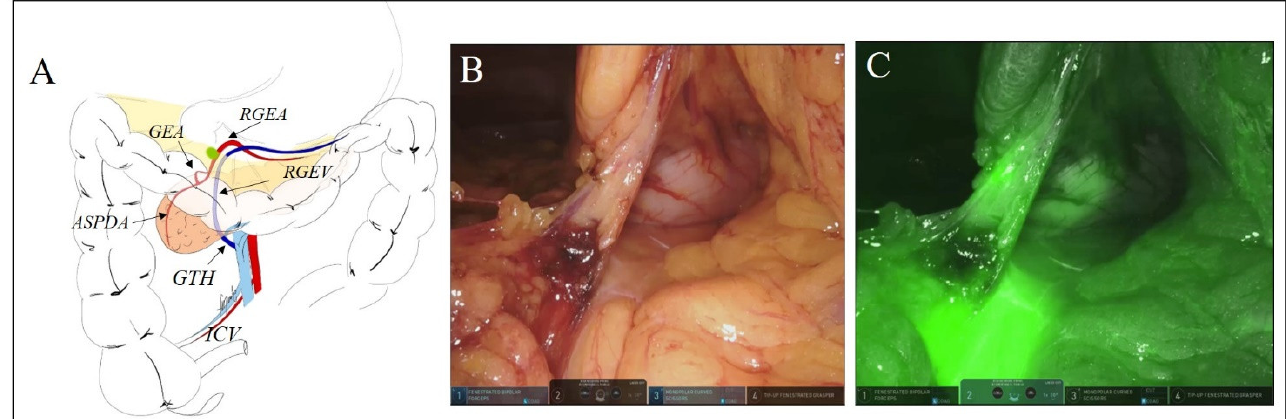
Figure 2. Sketch of the surgical field ( A ) and corresponding intraoperative pictures under white ( B ) and NIR ( C ) light of a female patient (#GLTr 7) undergoing robotic right colectomy with complete mesocolic excision and D3 lymphadenectomy with a bottom-to-up approach for a cancer of the ascending colon. With NIR light, a fluorescent node is visualized on the right gastroepiploic vessels (ICV: ileocolic vessels; GTH: gastroduodenal trunk of Henle; RGEV: right gastroepiploic vein; RGEA: right gastroepiploic artery; ASPDA: anterior superior pancreaticoduodenal artery; GEA: gastroduodenal artery).